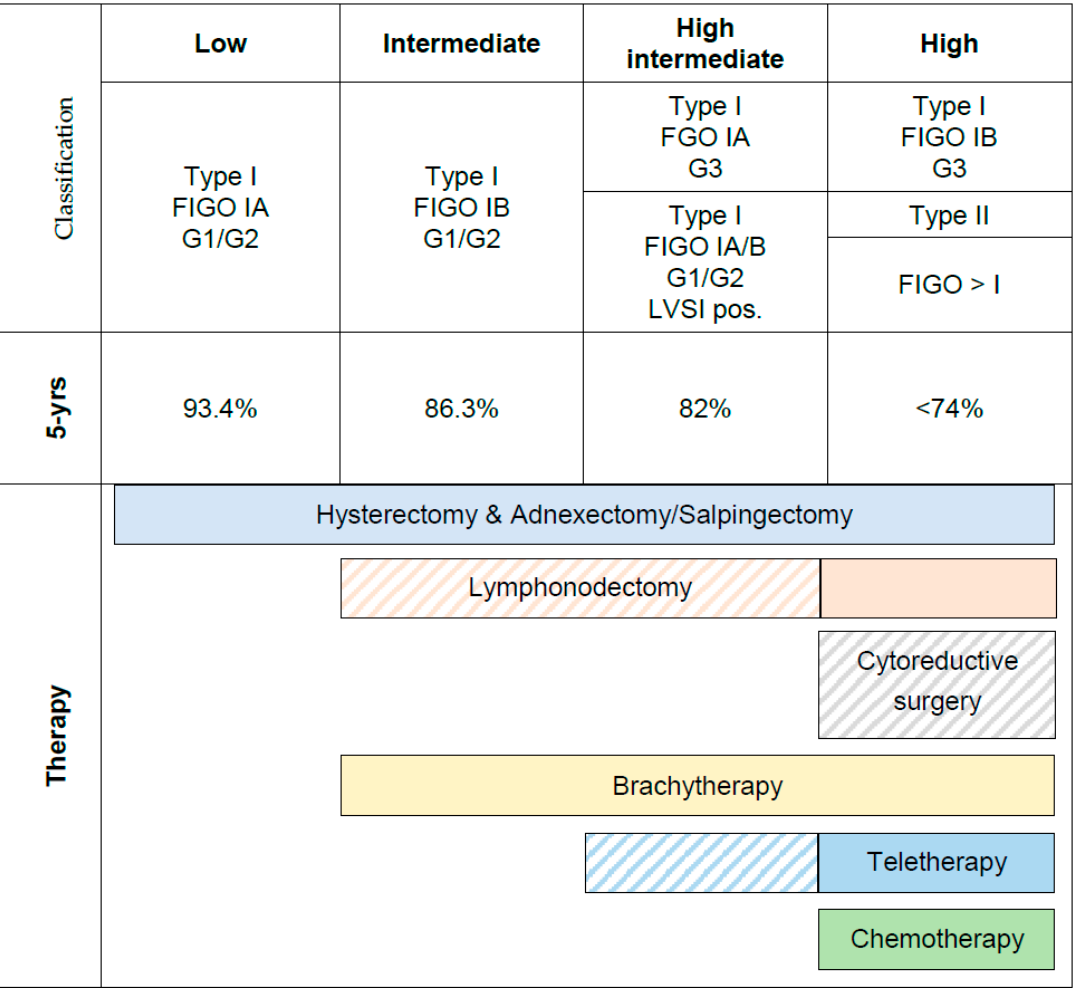
Figure 1. Current recommendations on risk stratification and therapy based on classical clinical risk factors and five-year overall survival (modified from AGO S3-Guideline).